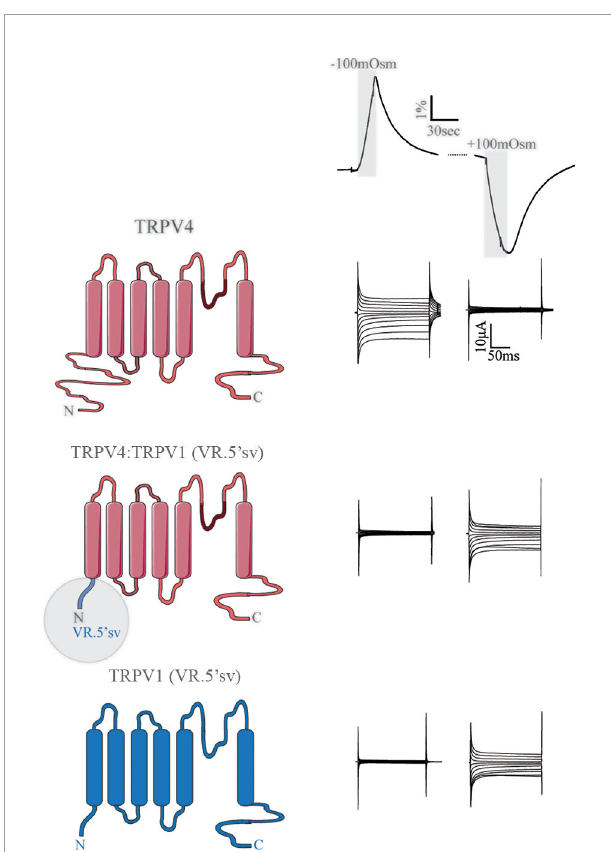
FIGURE 4 | The N-terminus of TRPV4 dictates the directionality of the volume sensing. Channel structures of TRPV4 (top), TRPV4:TRPV1 (VR.5'sv) chimera (with the TRPV4 N terminus replaced by that of VR.5 ’ sv, middle) and VR.5 ’ sv (bottom). The constructs were co-expressed with AQP4 in Xenopus laevis oocytes, which were exposed to a hyposmotic or hyperosmotic gradient ( D 100 mOsm) leading to robust cell swelling or cell shrinkage (volume trace, top). TRPV4 responded with augmented membrane currents to a cell volume increase unless its N-terminus was replaced by that of the shrinkage-sensitive VR.5 ’ sv variant of TRPV1 (middle and right panels). Modi fi ed from